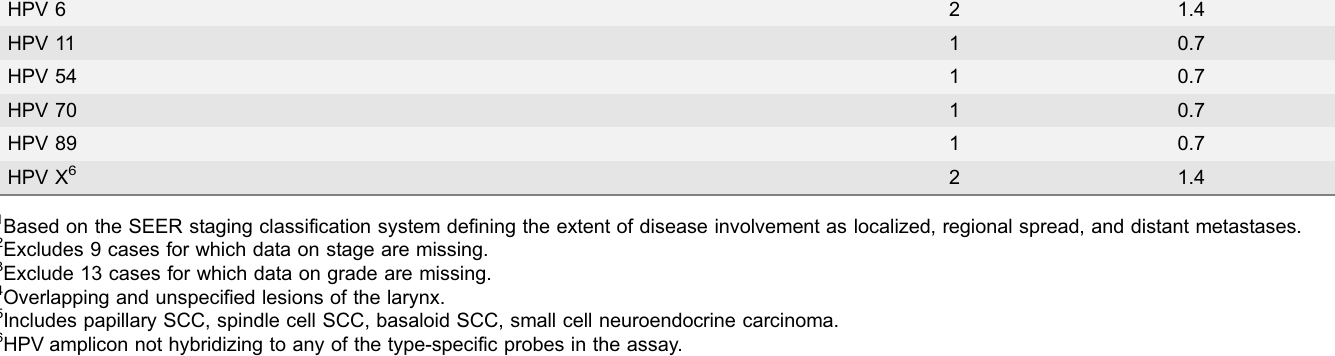
contained a single genotype. Carcinogenic HPV types (alone or in combination with non-carcinogenic types) were detected in 26 of the 31 HPV-positive tumors. Carcinogenic HPV 16 and HPV 33 were the most commonly detected genotypes. These two genotypes were each detected in 9 tumor specimens including 6 cases in which they were the sole genotype. Other carcinogenic genotypes included HPV 18, HPV 31, HPV 35, HPV 39, HPV 51, and HPV 66. Non-carcinogenic HPV types included HPV 6, HPV 11, HPV 54, HPV 70, and HPV 89. Two cases were HPV X, the designation used for an HPV amplicon that did not hybridize to any of the type-specific probes in the assays. The relationship of HPV status with case characteristics was evaluated ( Table 2 ). In crude analyses, nonsignificant differences (0.05 # P # 0.10) were observed by sex, year of diagnosis, and stage. HPV was detected in 33% of tumors in women compared with 18% of tumors in men ( P 5 0.08). Of patients diagnosed in 1999–2004, 28% were HPV-positive compared with 17% diagnosed in 1993– 1998 ( P 5 0.09). HPV was detected in 30% of advanced staged cancers and 17% of early stage cancers and ( P 5 0.07). Comparisons of HPV status by histological classification were not possible due to limited subtype numbers.